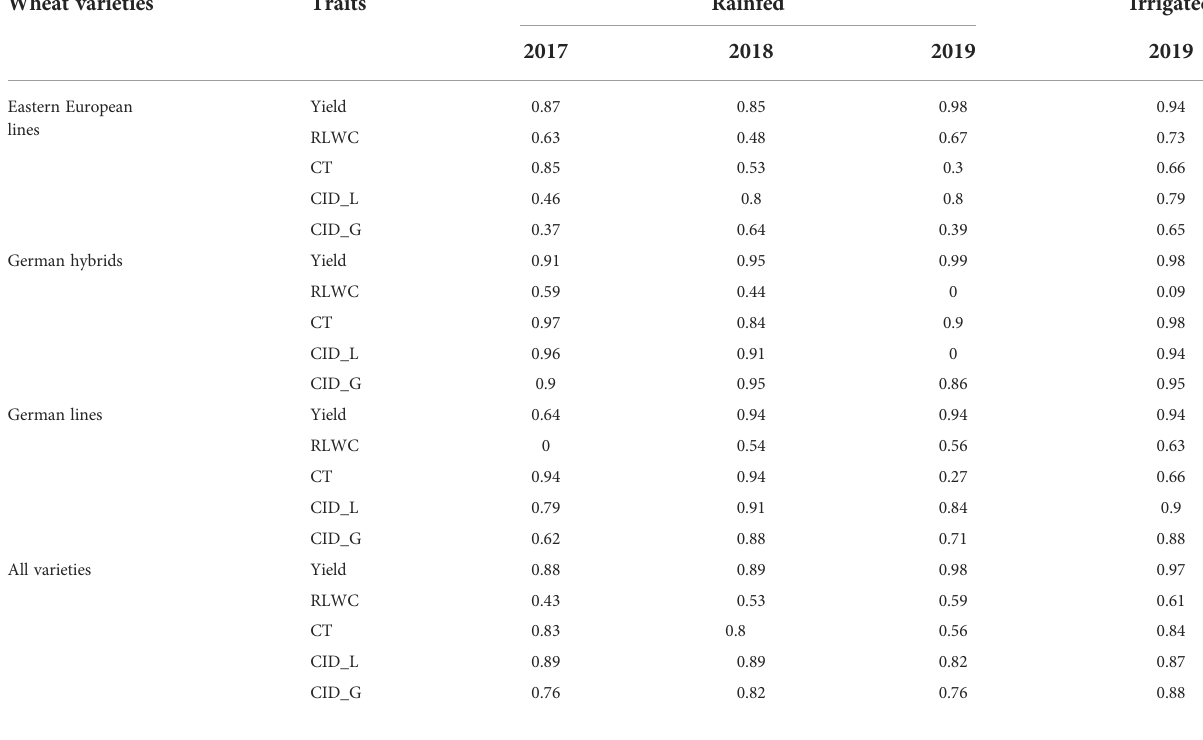
TABLE 7 Heritability of wheat grain yield, relative water content (RLWC), canopy temperature (CT), and carbon isotope discrimination (CID) in leaves (CID_L) and grains (CID_G) of wheat groups (all varieties, Eastern European lines, German hybrids, and German lines) under rainfed and irrigated fi eld conditions in Moldova in 2017, 2018 and 2019. Wheat varieties